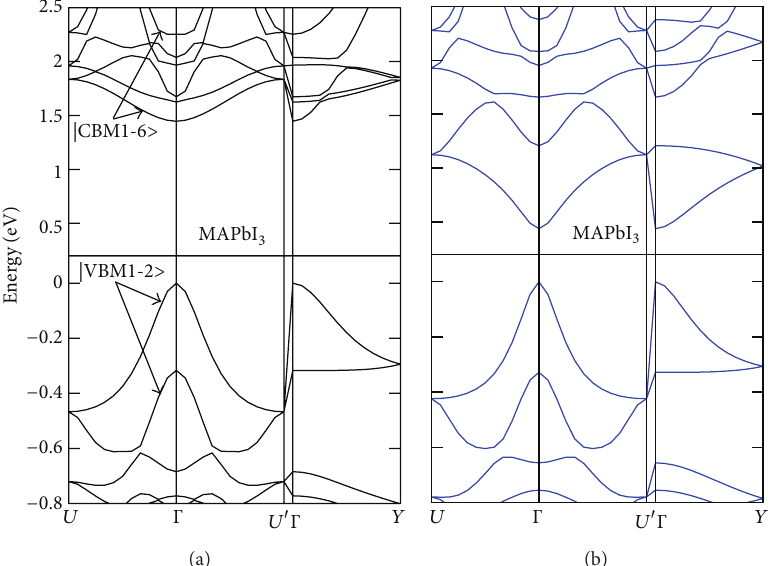
Figure 2: Electronic band structures of CH 3 NH 3 PbI 3 without (a) and with (b) SOC calculated at the LDA level. The origin of the energy scale is taken at the top of the VB.